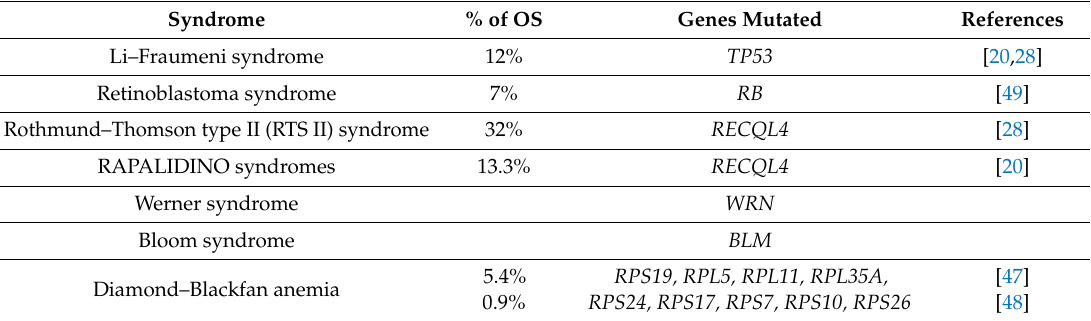
Table 1. Hereditary syndromes resulting in osteosarcoma